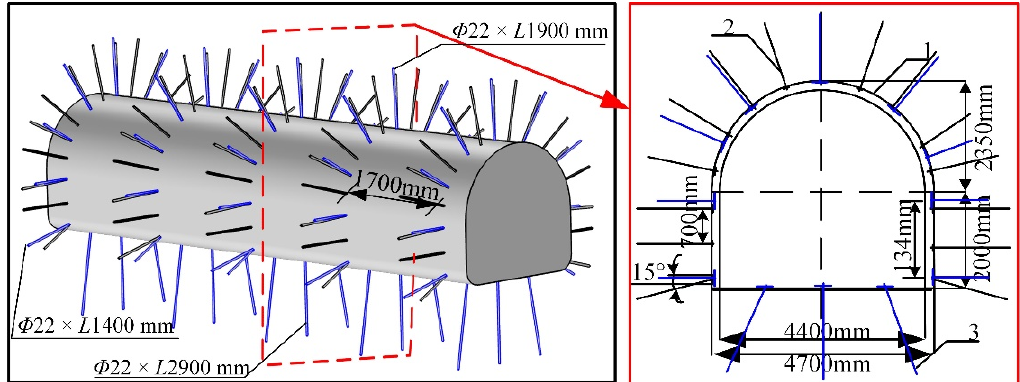
Figure 12. Bolt-grouting support scheme for roadway. 1—Sprayed concrete; 2— Φ 22 × L 2000 mm